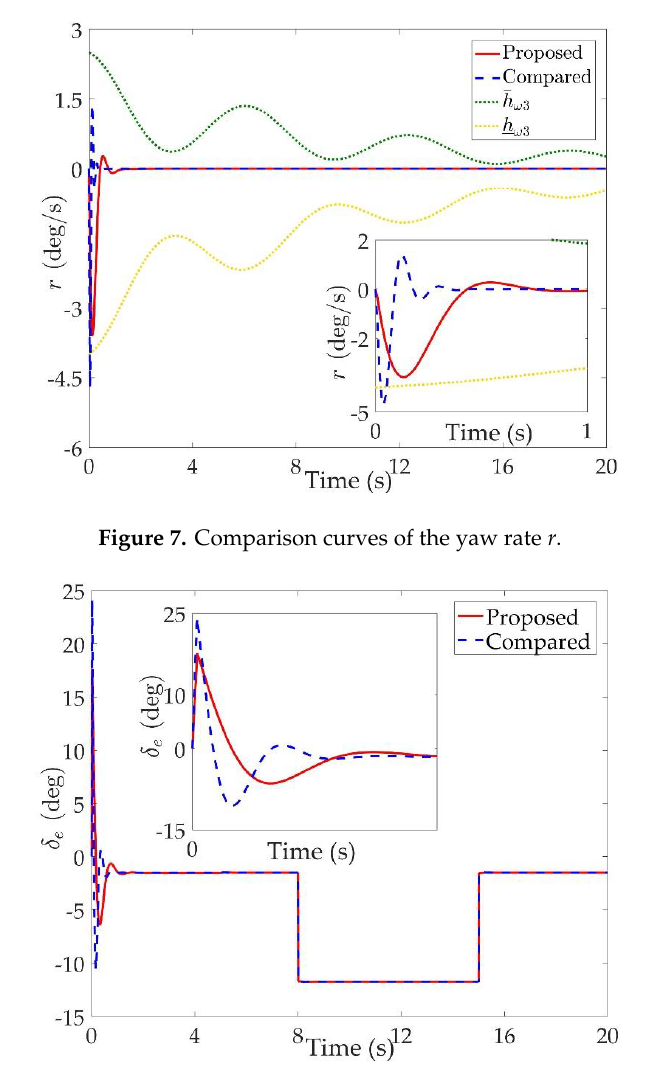
1 Figure 9. Comparison curves of the right elevon.